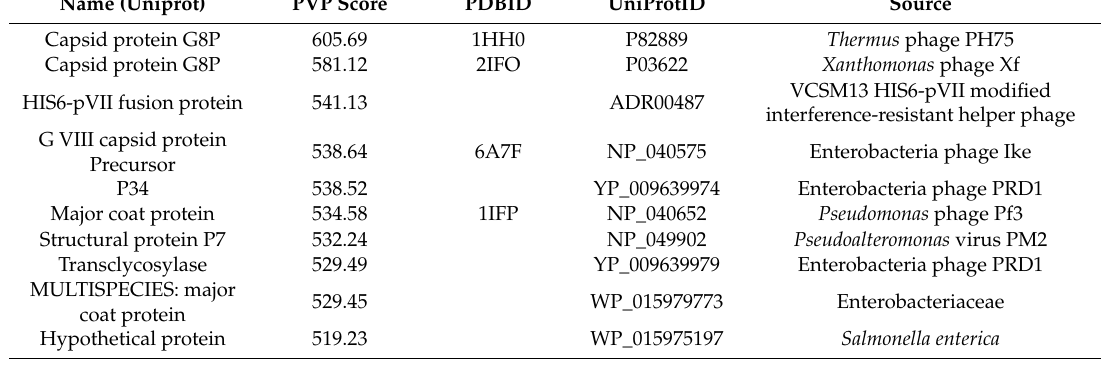
Table 6. Top ten potential phage virion proteins having the highest of their PVP scores.